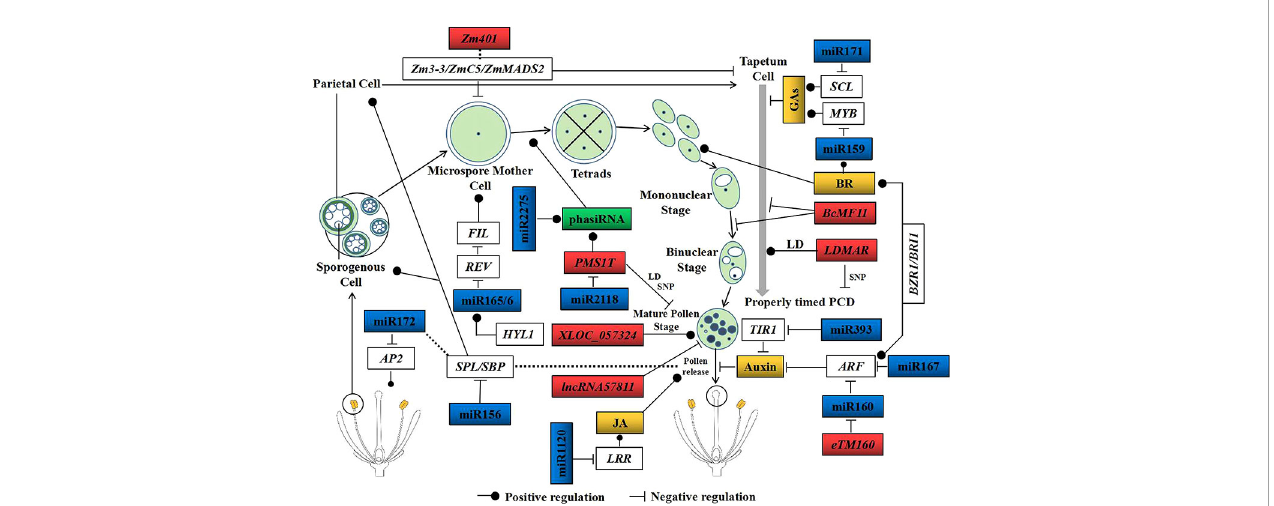
FIGURE 3 Critical non-coding RNAs (ncRNAs) participate in male organ development. Male organ development consists of six stages: the sporogenous cell stage, microspore cell stage, tetrad stage, mononuclear stage, binuclear stage, and the mature pollen stage. The blue rectangles represent the miRNAs that participate in male sterility, the red rectangles indicate the long non-coding RNAs (lncRNAs) related to pollen development in crops, the green rectangles indicate the phased small interfering RNAs (phasiRNAs) found in crops, and the yellow rectangles indicate the plant hormones involved in male organ development. NcRNAs participate in the dependence or non-dependence of male sterility on hormones. Among them, miR160, miR167, miR393, miR171, miR159, miR1120, and eTM160 regulate pollen development mediated by auxin, BRs, GAs, and JA. Others function by regulating the transcription factors or methylation levels. The dashed line denotes indirect regulation and control. MYB , MYB domain protein; SCL , scarecrow-like protein; ARF , auxin response factor; TIR , transport inhibitor response protein; SPL , SQUAMOSA promoter binding protein-like; FIL , fi lamentous fl ower; HYL1 , hyponastic leaves 1; LD, long-day condition; SNP, single nucleotide polymorphism; BRs , brassinosteroids; JA , jasmonate; GAs ,